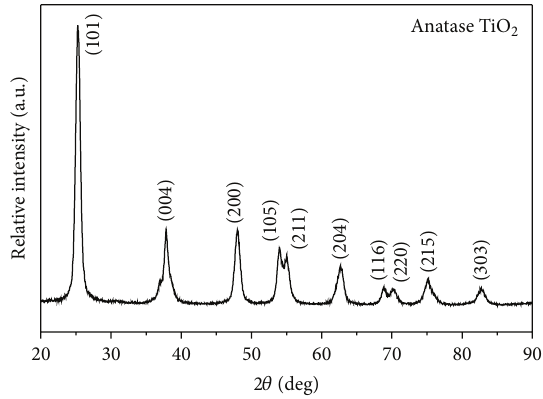
Figure 1: XRD patterns of the as-synthesized TiO 2